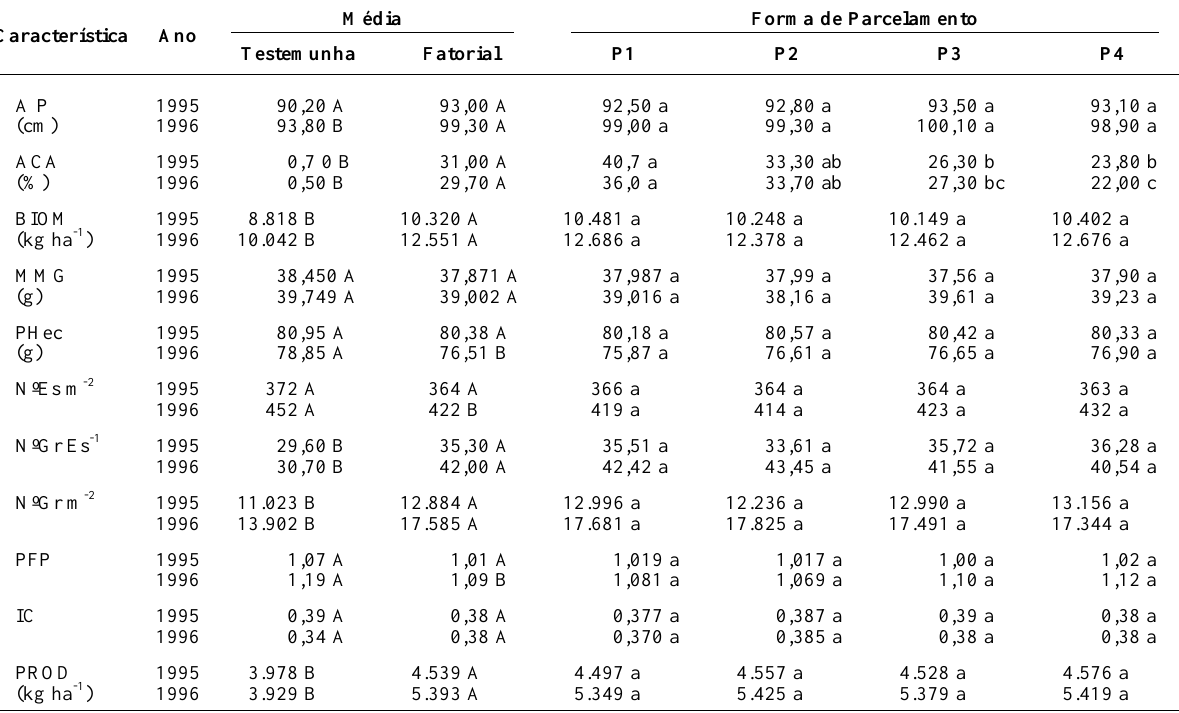
Quadro 1. Médias comparadas entre a testemunha e o fatorial e entre as formas de parcelamento,